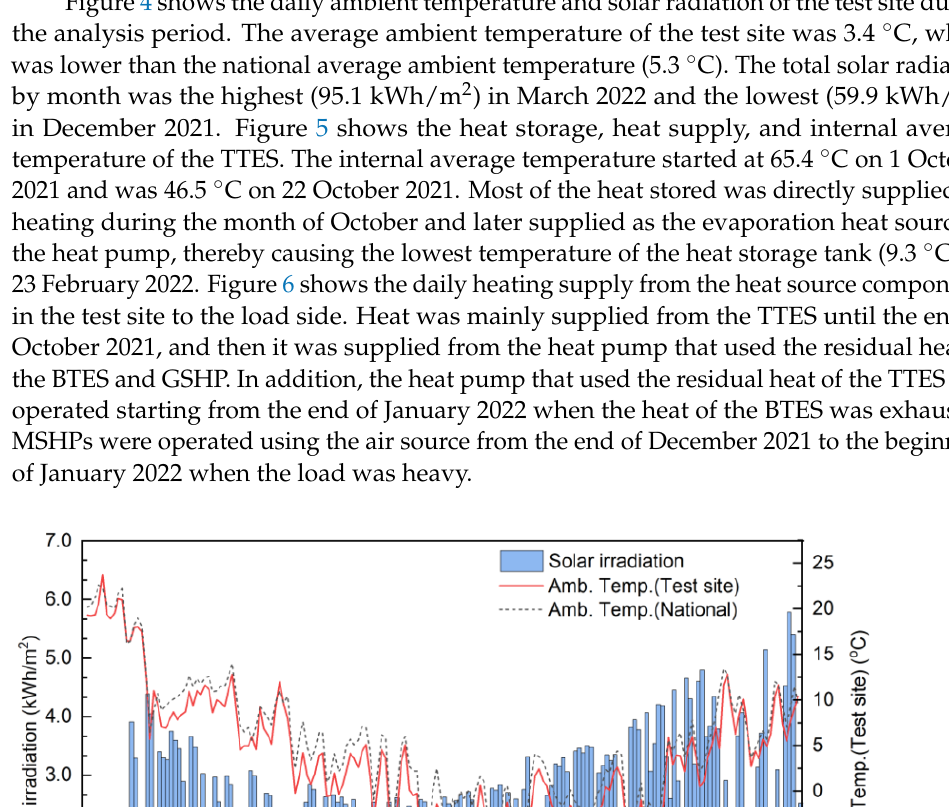
Figure 6. Daily heating supply of each component.